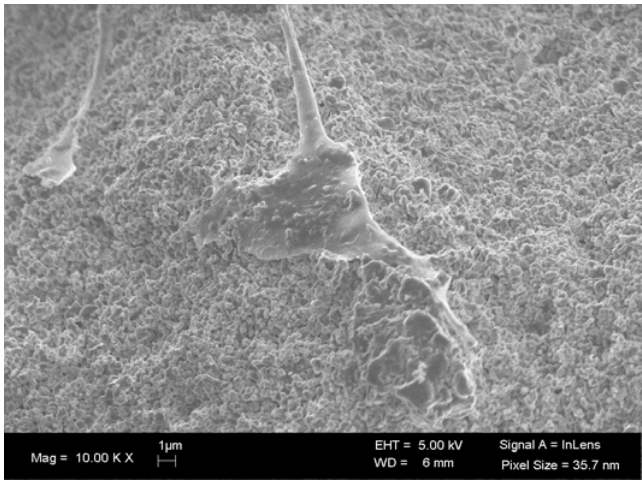
Figure 2. SEM image of human mesenchymal stem cells seeded onto a nanostructured BCP (Osteosynt